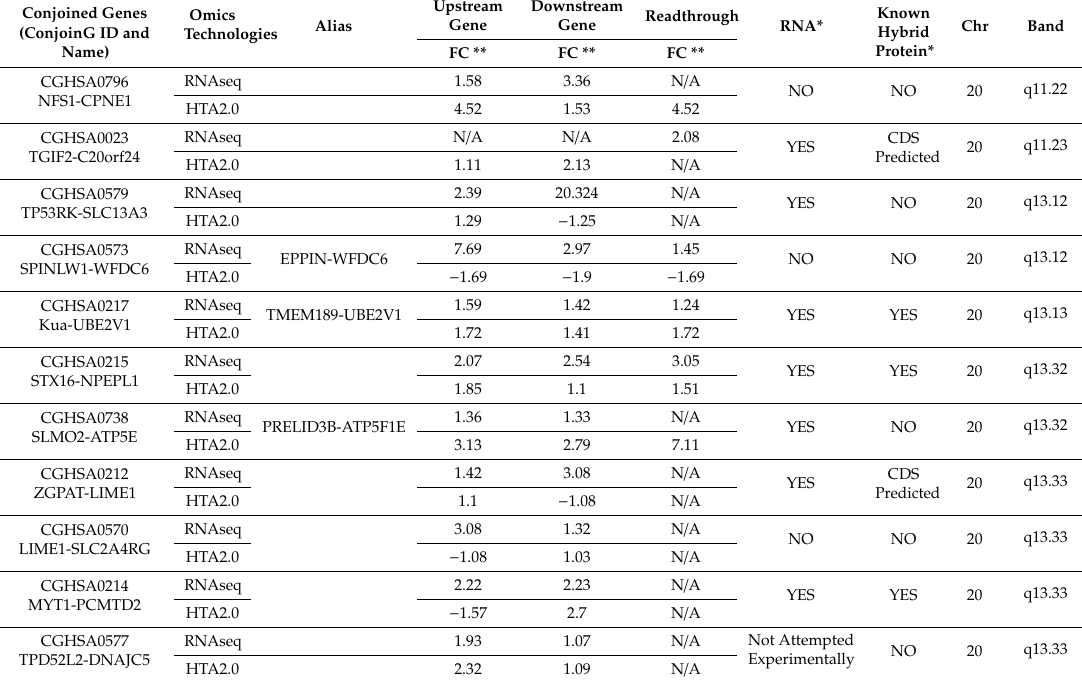
Table 2. FuTAGs located in Chr20q and upregulated in comparison with normal mucosa in both parent genes. Data obtained by RNAseq have been explored in HTA 2.0. Conjoined Genes (ConjoinG ID